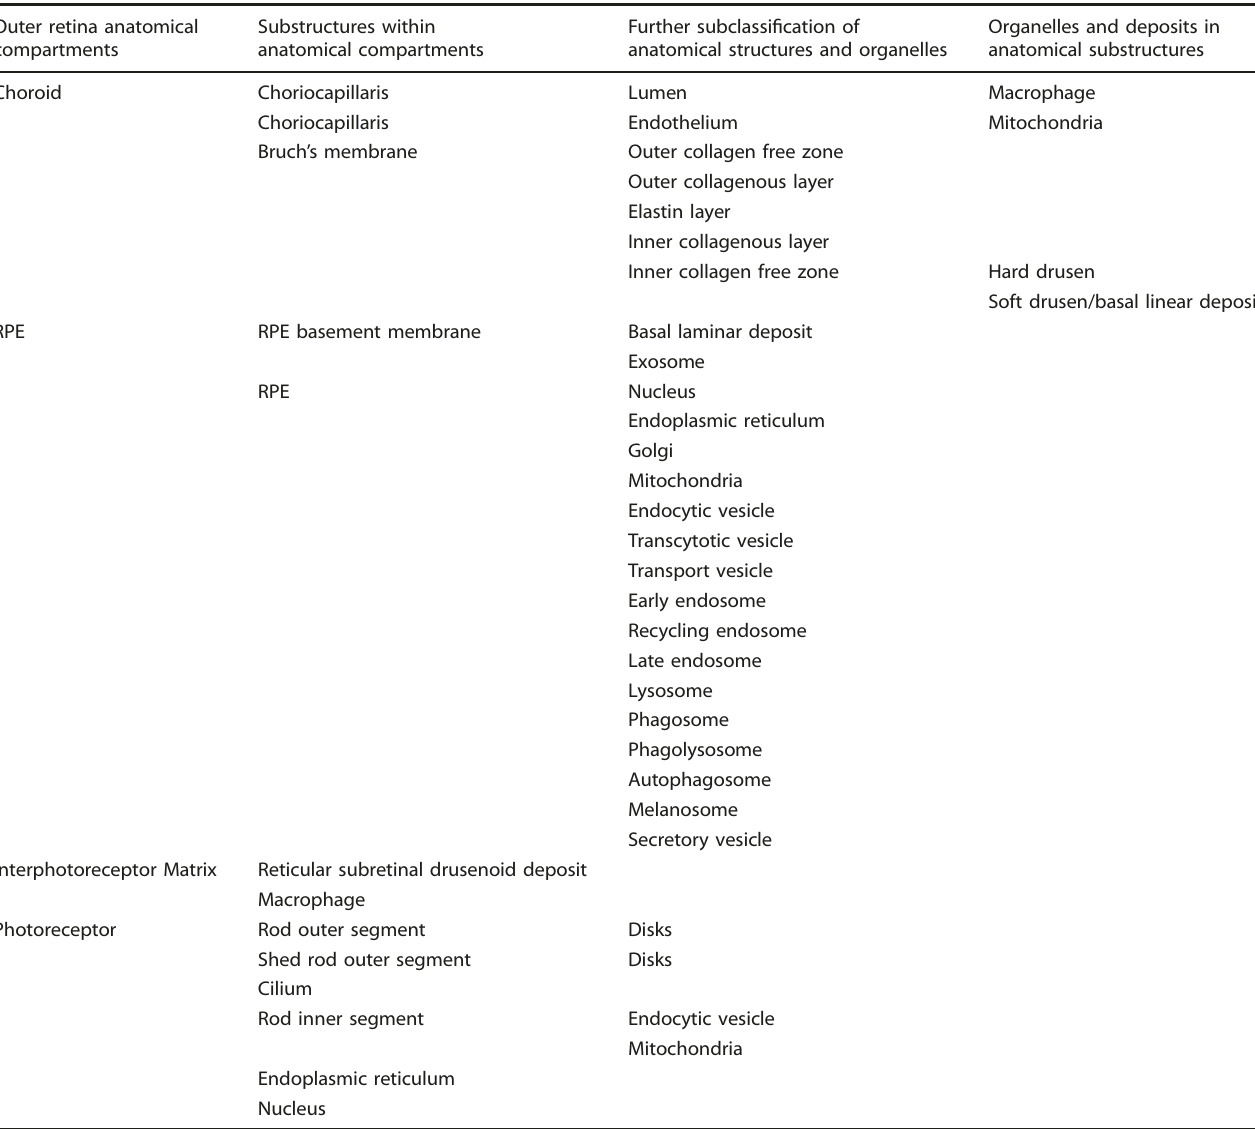
Table 1. Compartments created in the CellDesigner platform in line with the structure and function of the outer retina. Outer retina anatomical